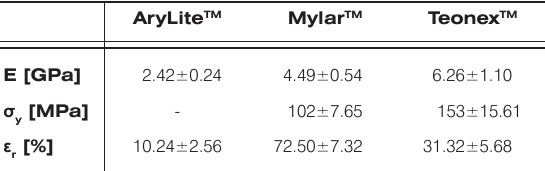
Table 2. Mechanical properties of Arylite TM , Teonex TM and Mylar TM . AryLite TM